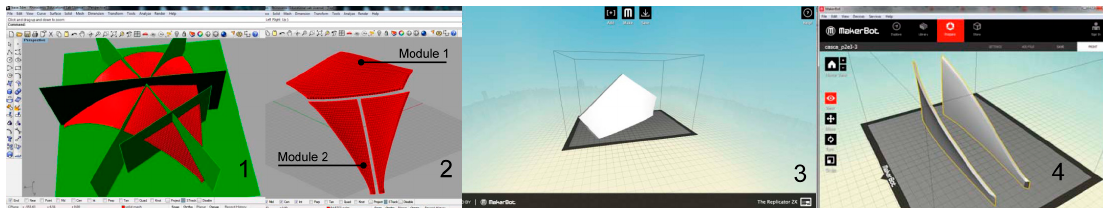
Figure 5. Preparation of 3D model for printing: ( 1 ) solid mesh subdivision; ( 2 ) modules; ( 3 , 4 ) printing volume of Replicator 2X (MakerBot Industries) for validation.